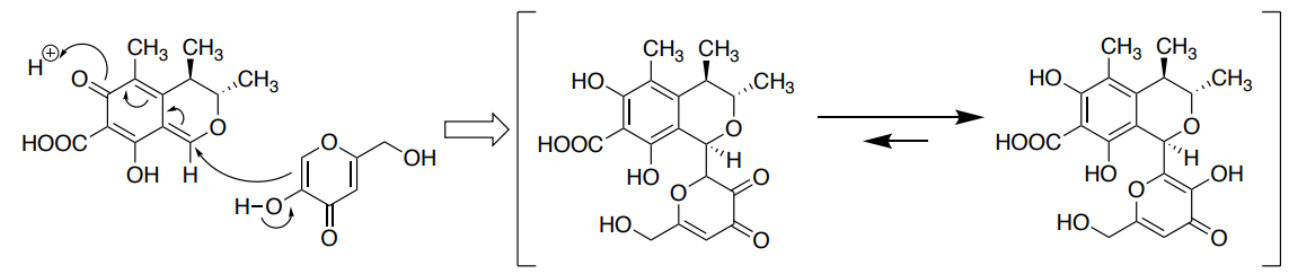
Figure 8. A proposed reaction mechanism for the formation of the CTN-KA adduct.